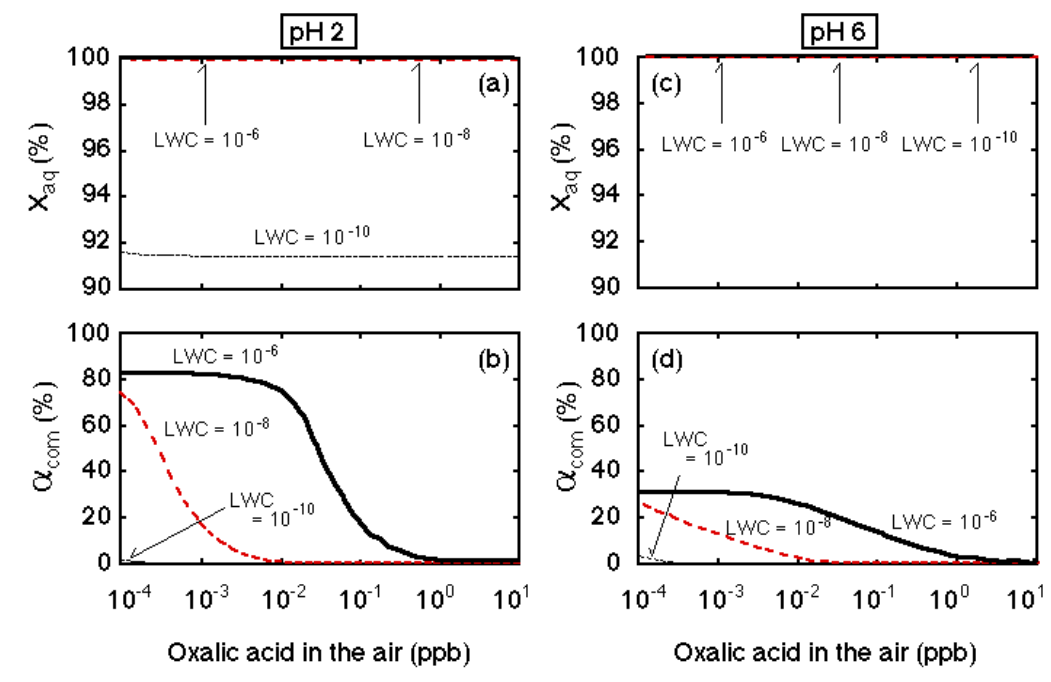
FIGURE 3 . The dissolution of oxalic acid gas into fog water in the presence of some trace transition: (a) the partition of oxalic acid between gas phase and fog water with pH 2; (b) the fraction of metal – oxalate concentration to total oxalic acid concentration in fog water with pH 2; (c) the partition of oxalic acid between gas phase and fog water with pH 6; (d) the fraction of metal – oxalate concentration to total oxalic acid concentration in fog water with pH 6. The calculation is based on the annual concentration of metals in fog water collected in Mt. Oyama,